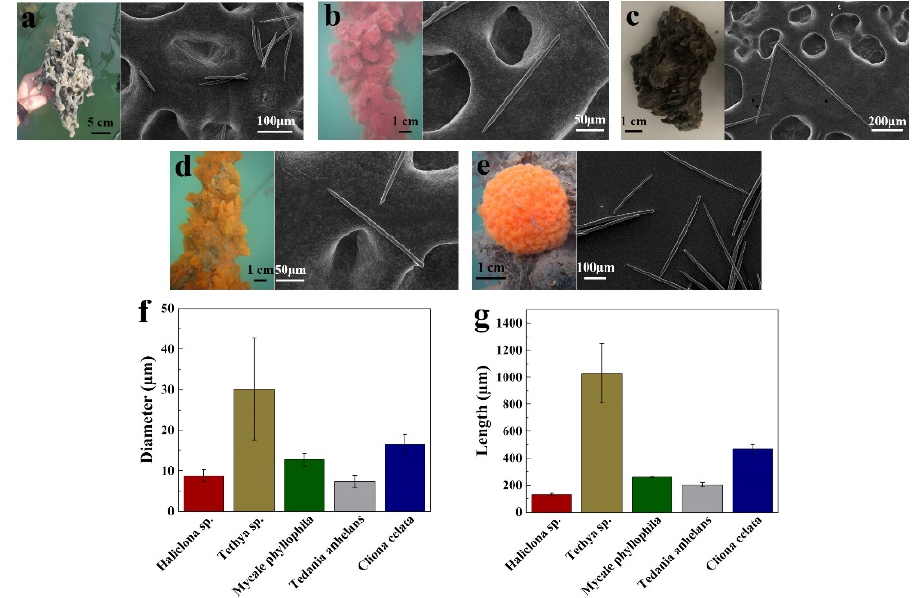
Figure 1. Visualization and characterization of different sponges and their spicules. ( a ) Sponge Haliclona sp. and its spicules. ( b ) Sponge Mycale phyllophila and its spicules. ( c ) Sponge Cliona celata and its spicules. ( d ) Sponge Tedania anhelans and its spicules. ( e ) Sponge Tethya sp. and its spicules. ( f ) Diameters of different sponge spicules. ( g ) Lengths of different sponge spicules.